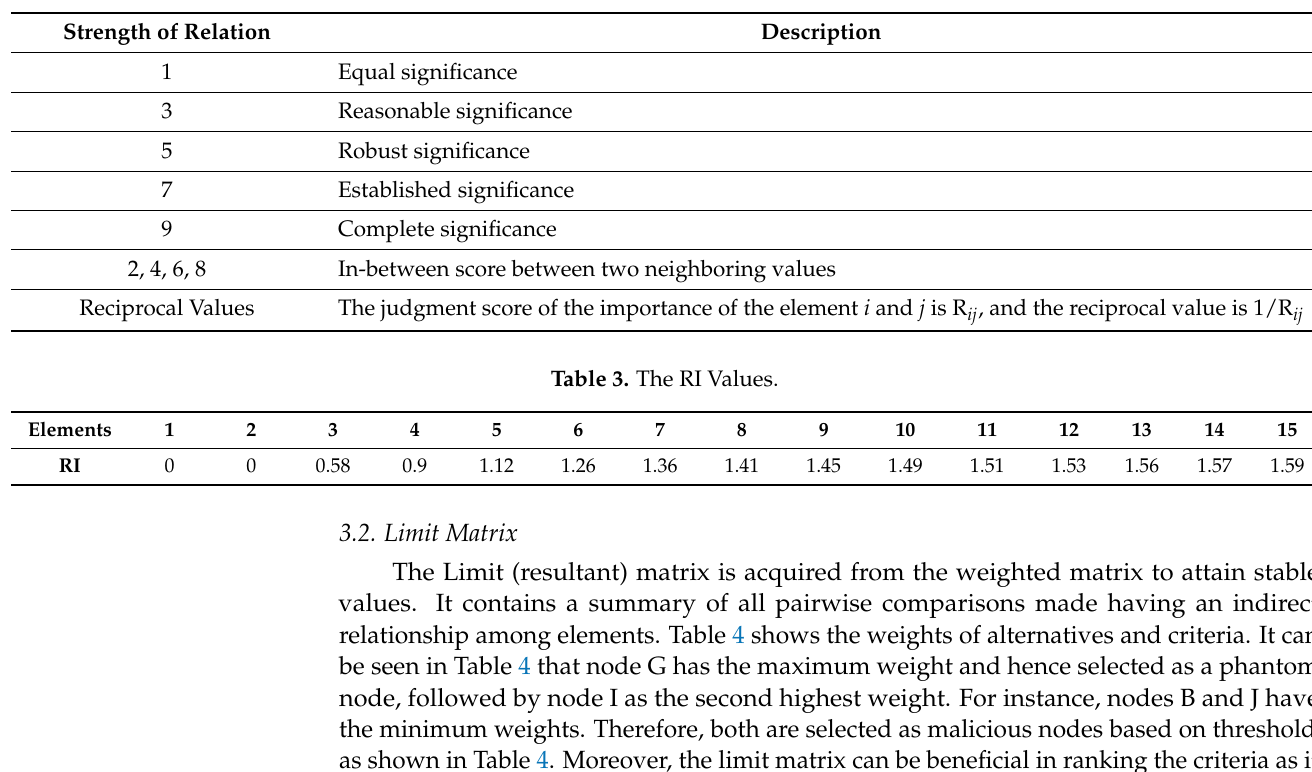
Table 2. I The intensity of relative importance.